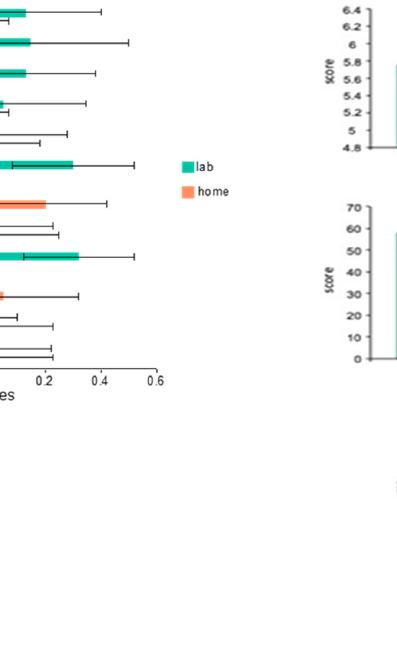
Figure 1. A : average standardized scores on the 12 Cambridge Brain Sciences (CBS) tasks taken at home and in the lab by 19 healthy young adult controls. The results showed no significant effect of at home versus in laboratory testing ( F = 1.71, p = 0.2); B : average raw scores on 4 CBS tasks as well as simple and choice reaction time tasks taken at home and in the lab by 27 patients with Parkinson’s Disease. Again, there was no significant effect of at home versus in-lab testing ( p > 0.1) and the tasks showed reliable correlations across the two testing environments ( p < 0.05).